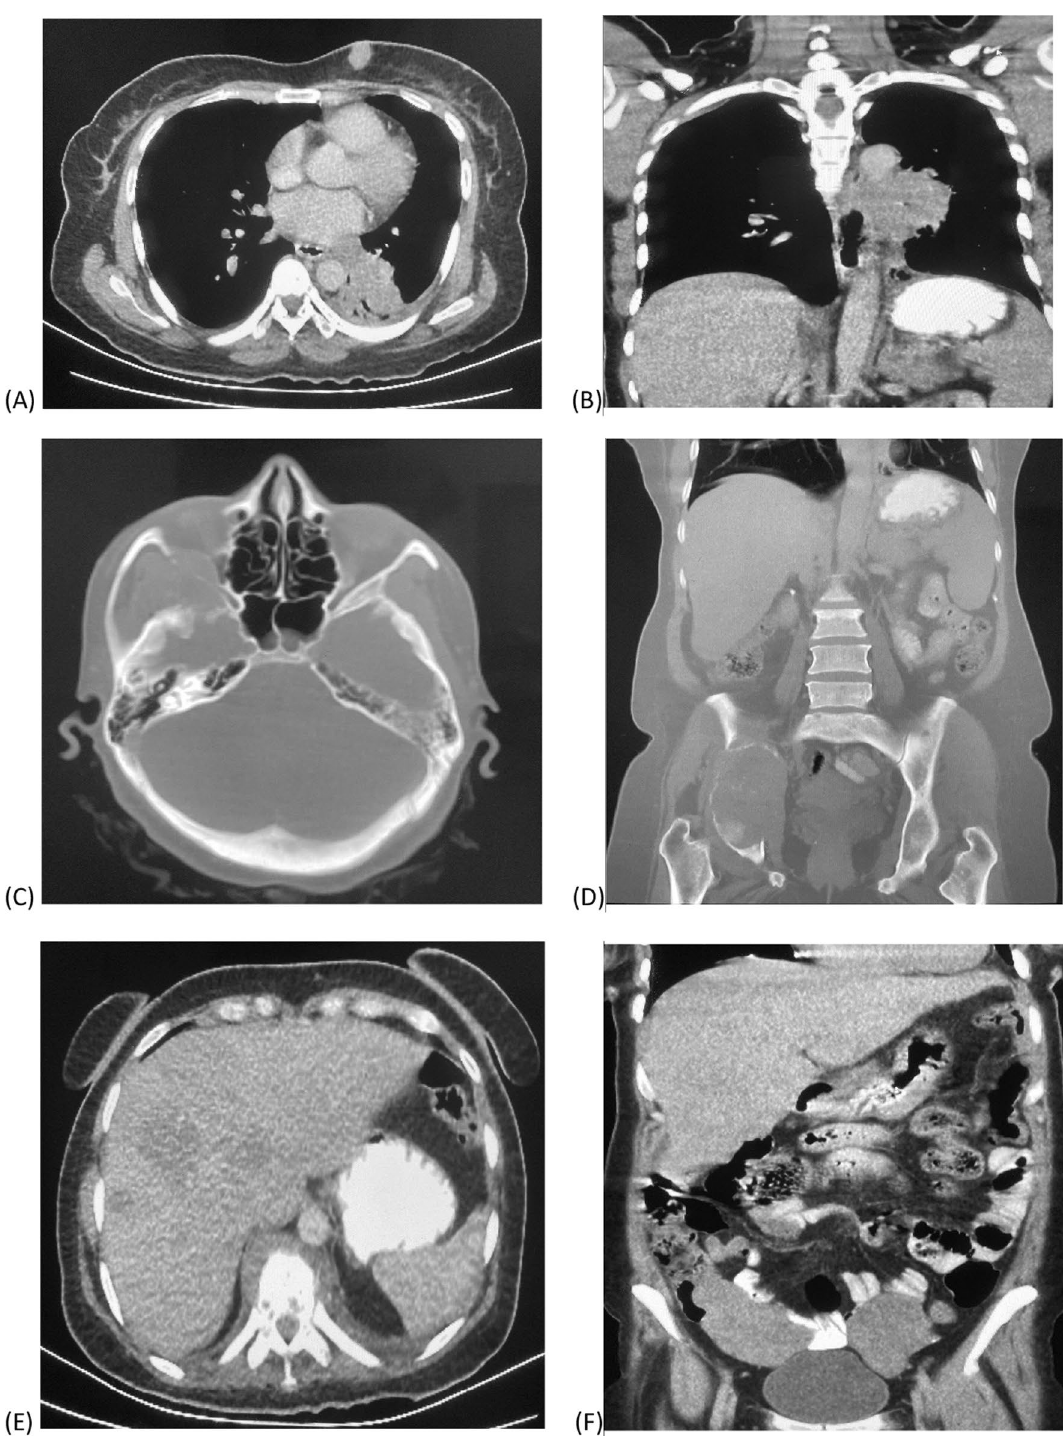
Fig. 3 Contrast-Enhanced staging CT. Thorax CT with axial and coronal ( A , B mediastinal window) show speculated soft tissue mass lesion that involves the posteroinferior segment of left lower lung lobe abutting the related vascular structures (descending aorta and left atrium) as well as infiltrating-related pleural reflections. It is not respecting related tissue plans. Skull base axial cut and pelvic bones coronal cut ( C , D bone window) show expansible destructive bony lesion seen involving right. Greater wing of sphenoid and Rt. Iliac bone with considerable soft tissue components, respectively. Abdomen and pelvis CT ( E , F ) axial and coronal soft tissue windows, respectively, show multiple hepatic focal lesions and bilateral solid adnexal